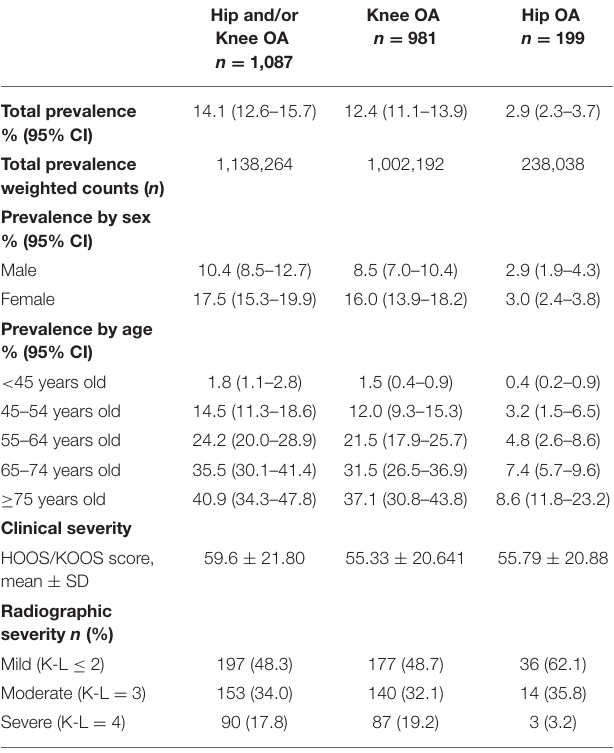
TABLE 1 | Estimated prevalence of HKOA by sex, age, and